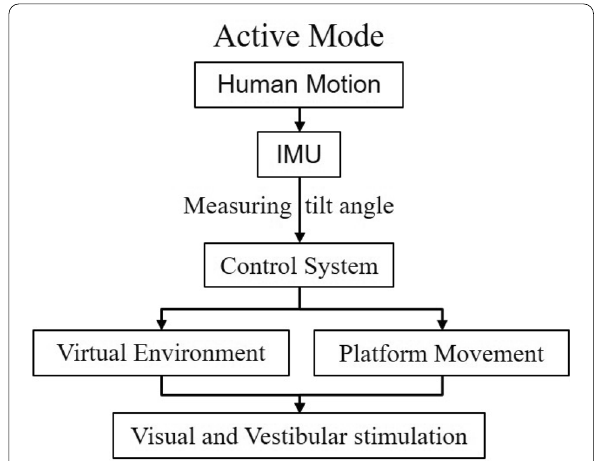
Figure 6 Flow of control signals in active mode